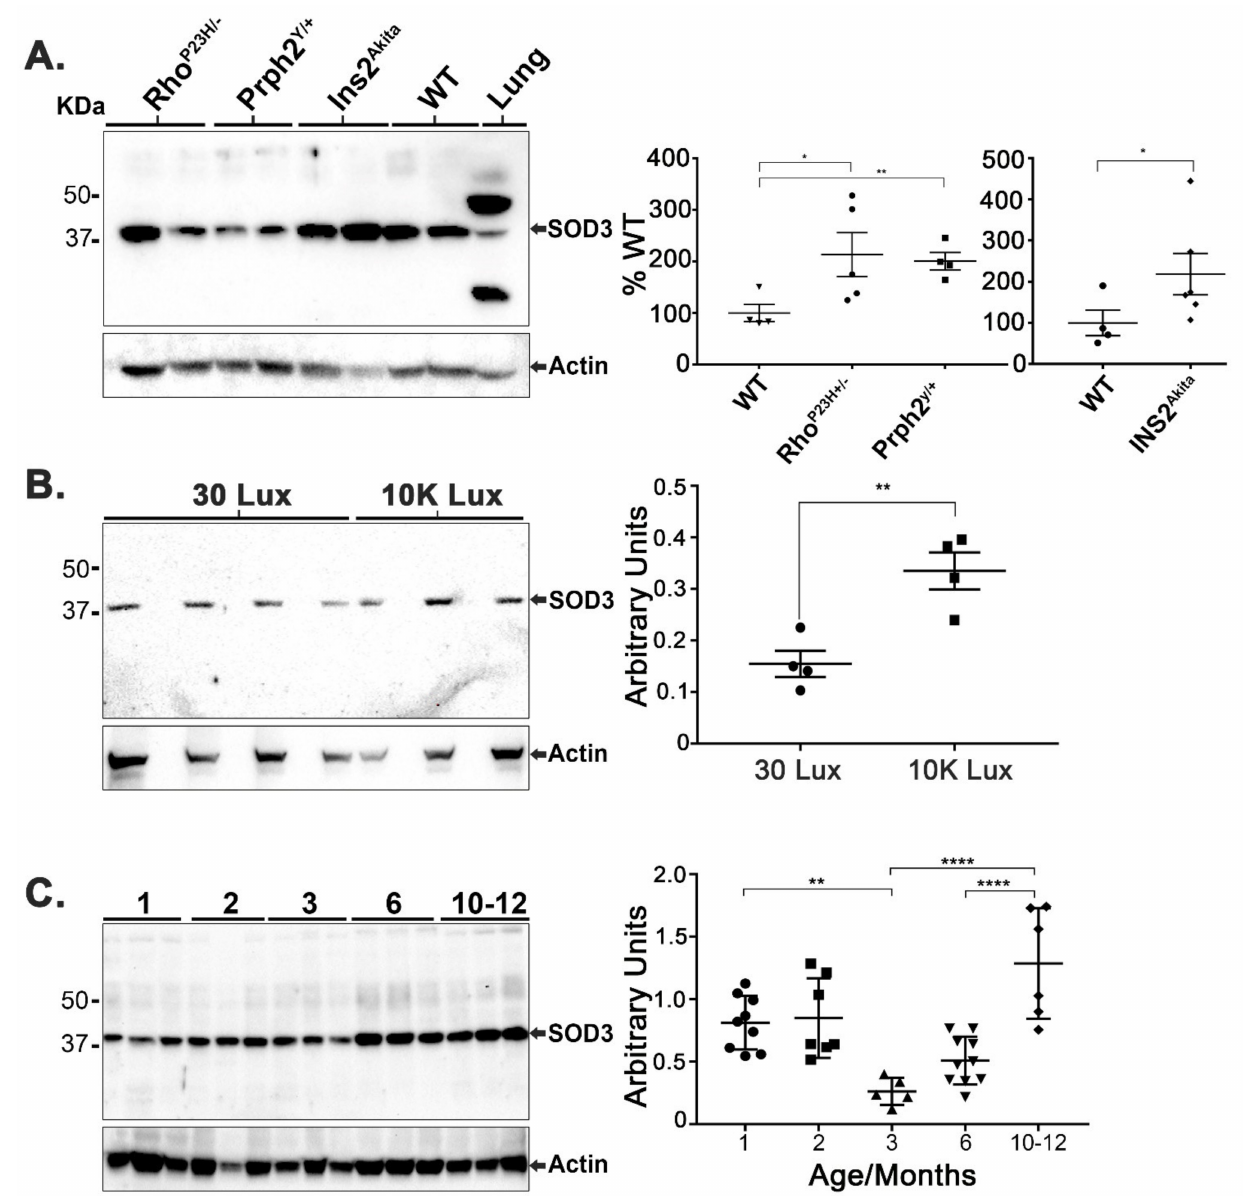
Figure 1. Retinal SOD3 steady state levels are modulated under pathogenic conditions, light stress, and during aging. ( A ) Retinas from 1 month old WT, Rho P23H+/ − and Prph2 Y/+ , and 10-month-old male INS2 Akita were collected and analyzed by immunoblotting for SOD3 levels. Rho P23H+/ − and Prp2 Y/+ retinas demonstrated a statistically significant increase in SOD3 levels (where p = 0.0267 and 0.0028, respectively). INS2 Akita retinas exhibited ~2.5 fold upregulation in SOD3 levels over the age-matched WT controls ( p = 0.0405). ( B ) 2-month-old WT agouti mice were placed under 10,000 lux light for 4 h and retinas were harvested one hour after light exposure. Compared with animals kept under 30 lux standard lighting conditions, there was a statistically significant upregulation of SOD3 ( p = 0.0482, n = 4). ( C ) WT retinas were collected at 1, 2, 3, 6, and 10 to 12 months of age. Retinal SOD3 levels were steady at 1 and 2 months then sharply declined at 3 months. The drop was determined to be statistically significant by one-way ANOVA and Tukey’s post-hoc analysis ( p = 0.0077) for the decline from 1 to 3 months ( p < 0.001) and for increases from 3 to 10 months as well as from 6 to 10 months. ( n = 4 to 9 for all samples). (* is p ≤ 0.05, ** is p ≤ 0.01, **** is p ≤